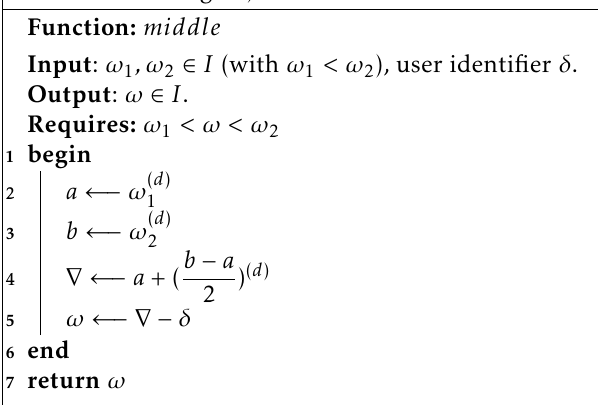
Figure 2. Situationforsingle